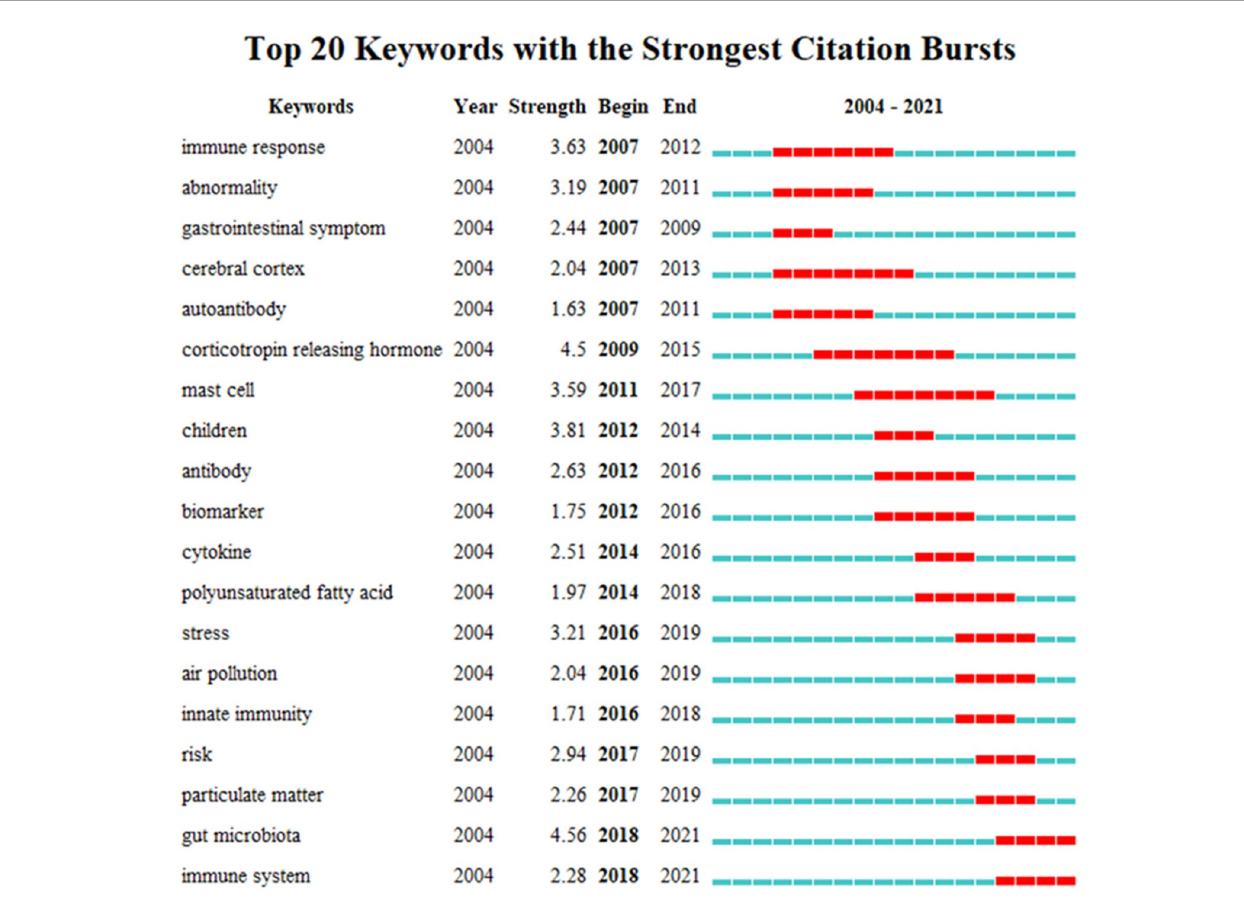
FIGURE9 The top 20 keywords with the strongest citation bursts based on CiteSpace. The red horizontal stripes represent the years with the most frequent keyword use. The green horizontal stripes represent the years with the most infrequent keyword